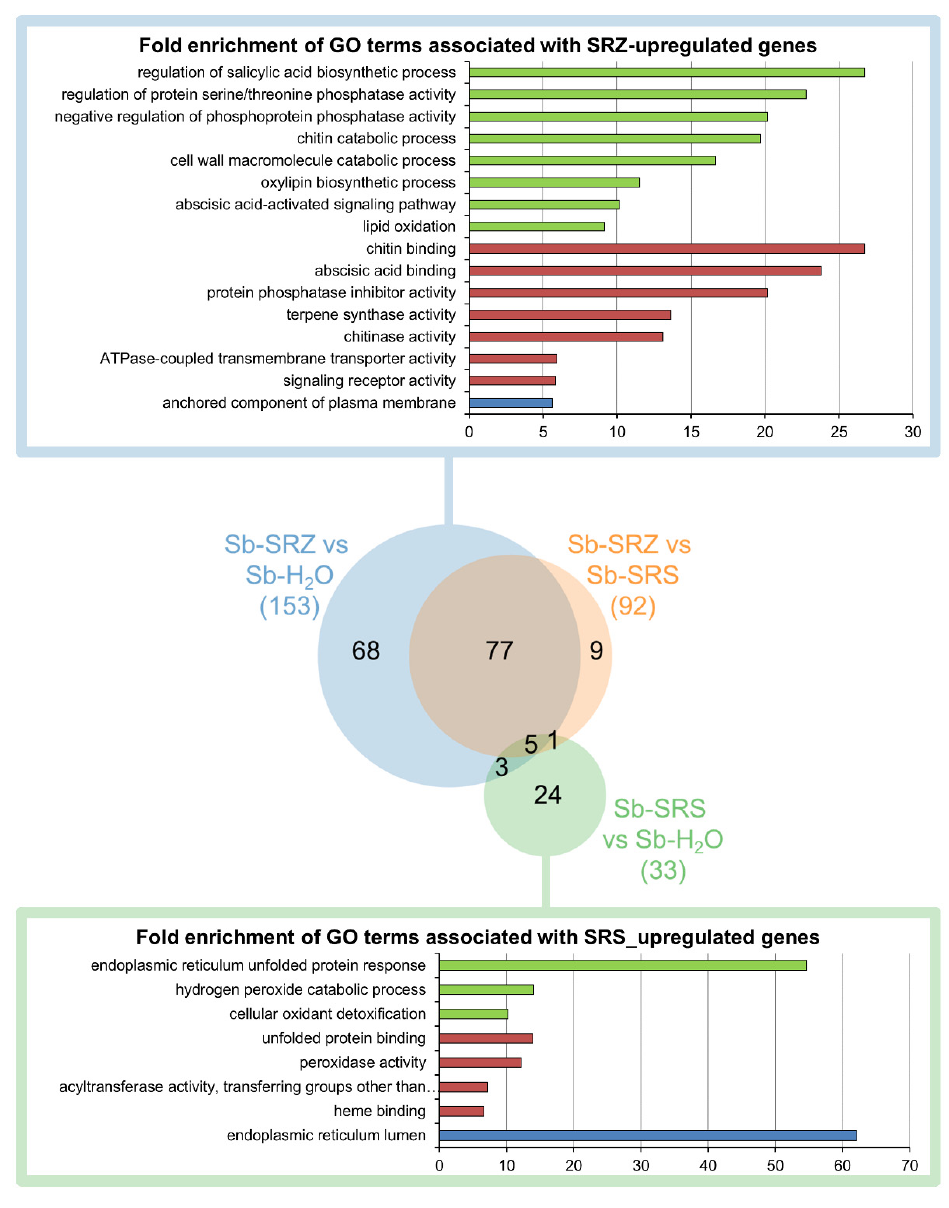
Figure 4. Overview of GO term analysis of differentially regulated sorghum genes. Fold enrichments of GO terms significantly overrepresented in the set of differentially regulated genes in all three GO categories (biological process, molecular function, cellular structure) for each of the three comparisons (Sb-SRZ vs. Sb-H 2 O, Sb-SRS-vs Sb-H 2 O, Sb-SRZ vs. Sb-SRS). Venn diagram created using the Venn Diagram Maker online from META-CHART. For the SRZ-induced genes, as well as for the SRS-induced genes, lists of the most significant GO terms are provided, selecting the youngest child term to represent a group of connected GO terms. Terms associated with biological process are represented in green, with molecular function in red and with cellular component in blue.